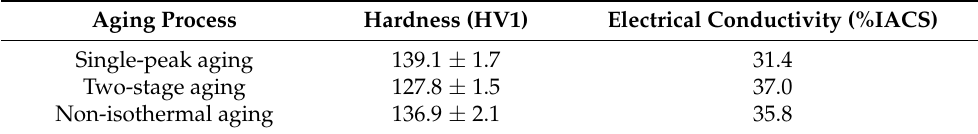
Table 6. The hardness and electrical conductivity of 7N01 extrusion aluminum alloy after different aging